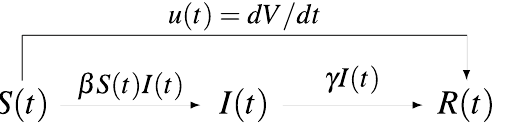
Figure 1. The A-SIRV epidemic